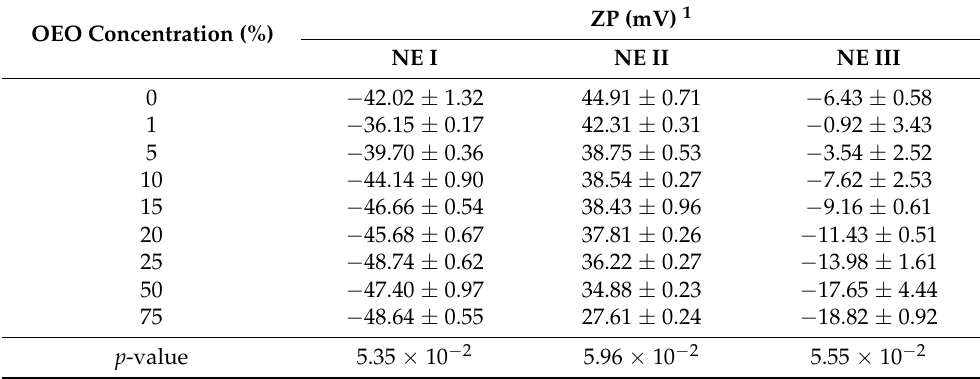
Table 1. Zeta potential (ZP) of NE I, II, and III for increasing oregano essential oil (OEO) concentrations.